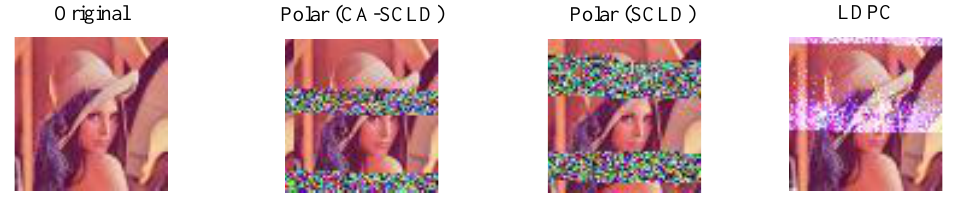
Figure 5. Decoding result of Lena image at SNR = 6.0 dB. Note that each pixel of the Lenna image has three values for red, green, and blue (RGB).